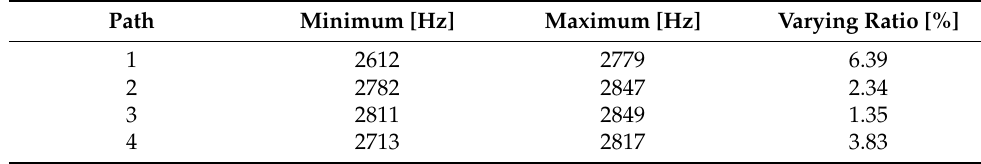
Table 3. Natural frequency variation of part during milling.